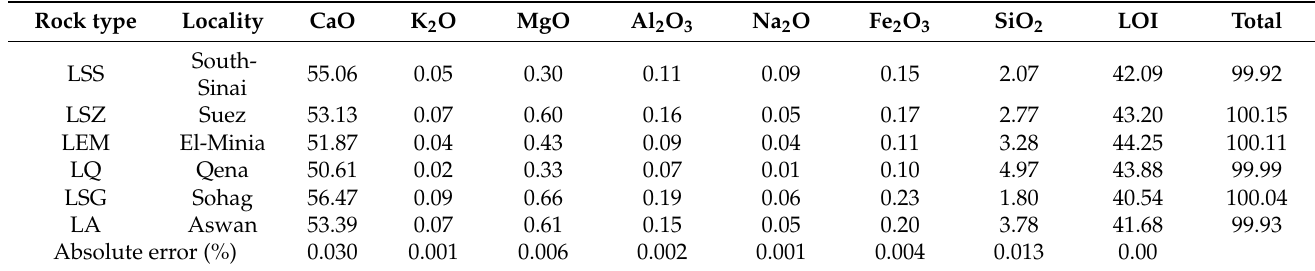
Table 2. XRF analysis of the studied limestones.